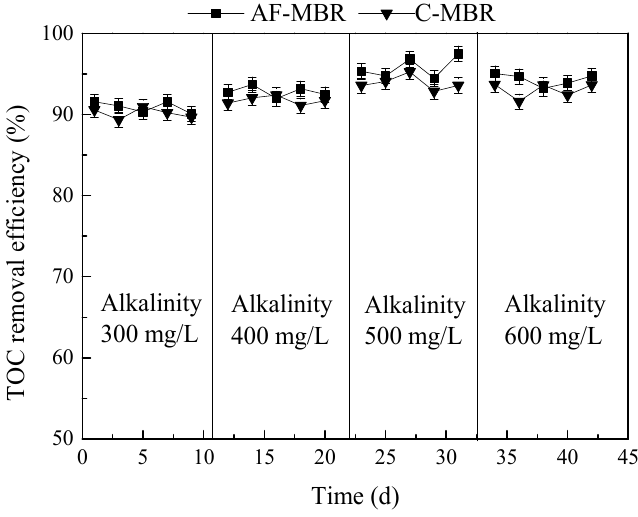
Figure 5. Influence of different influent alkalinity values on TOC removal efficiency.